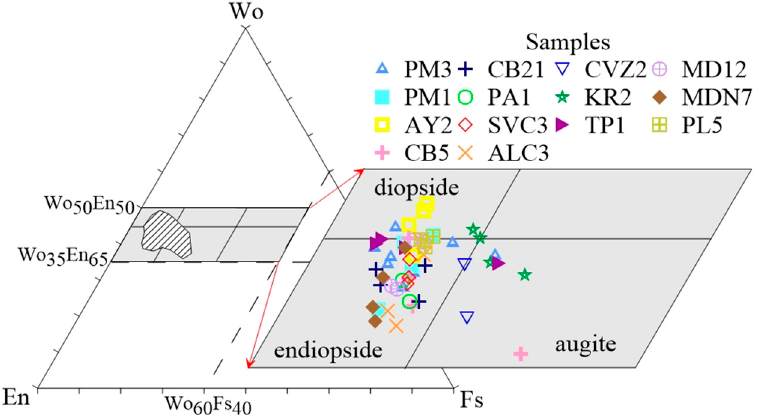
Figure 5. Compositional variation of clinopyroxene phenocrysts in the Yüksekova Complex in Wo-En-Fs triangle, after [51].